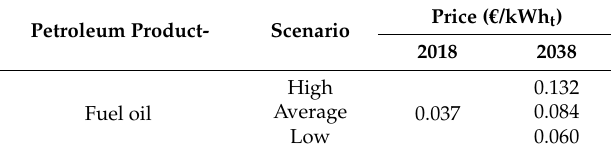
Table 11. Fuel oil price forecast, 2018–2038.